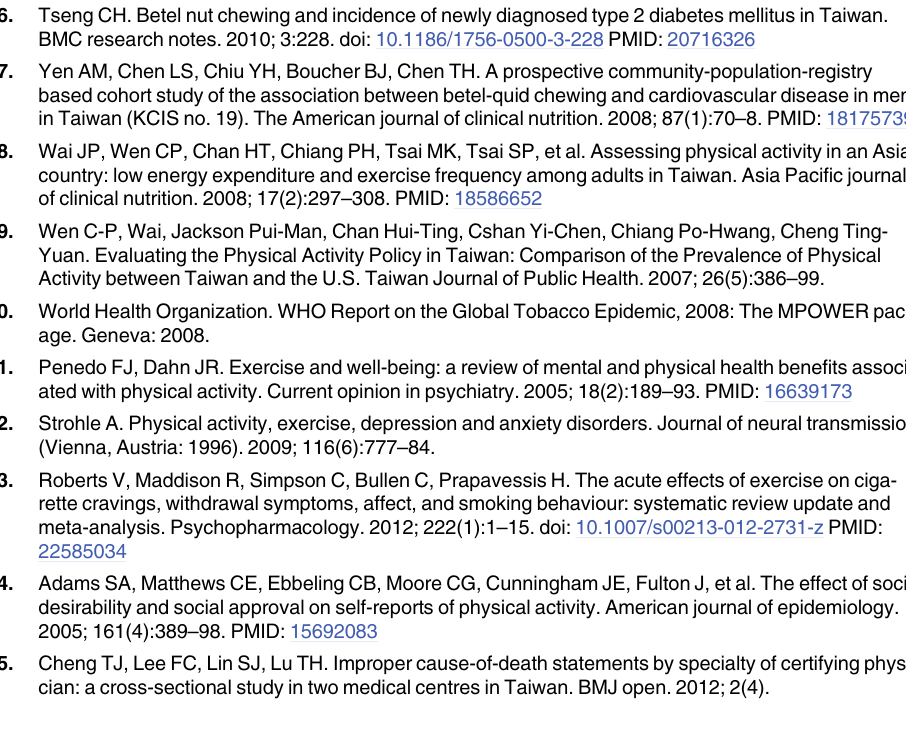
PLOS ONE | DOI:10.1371/journal.pone.0152246 April 4,